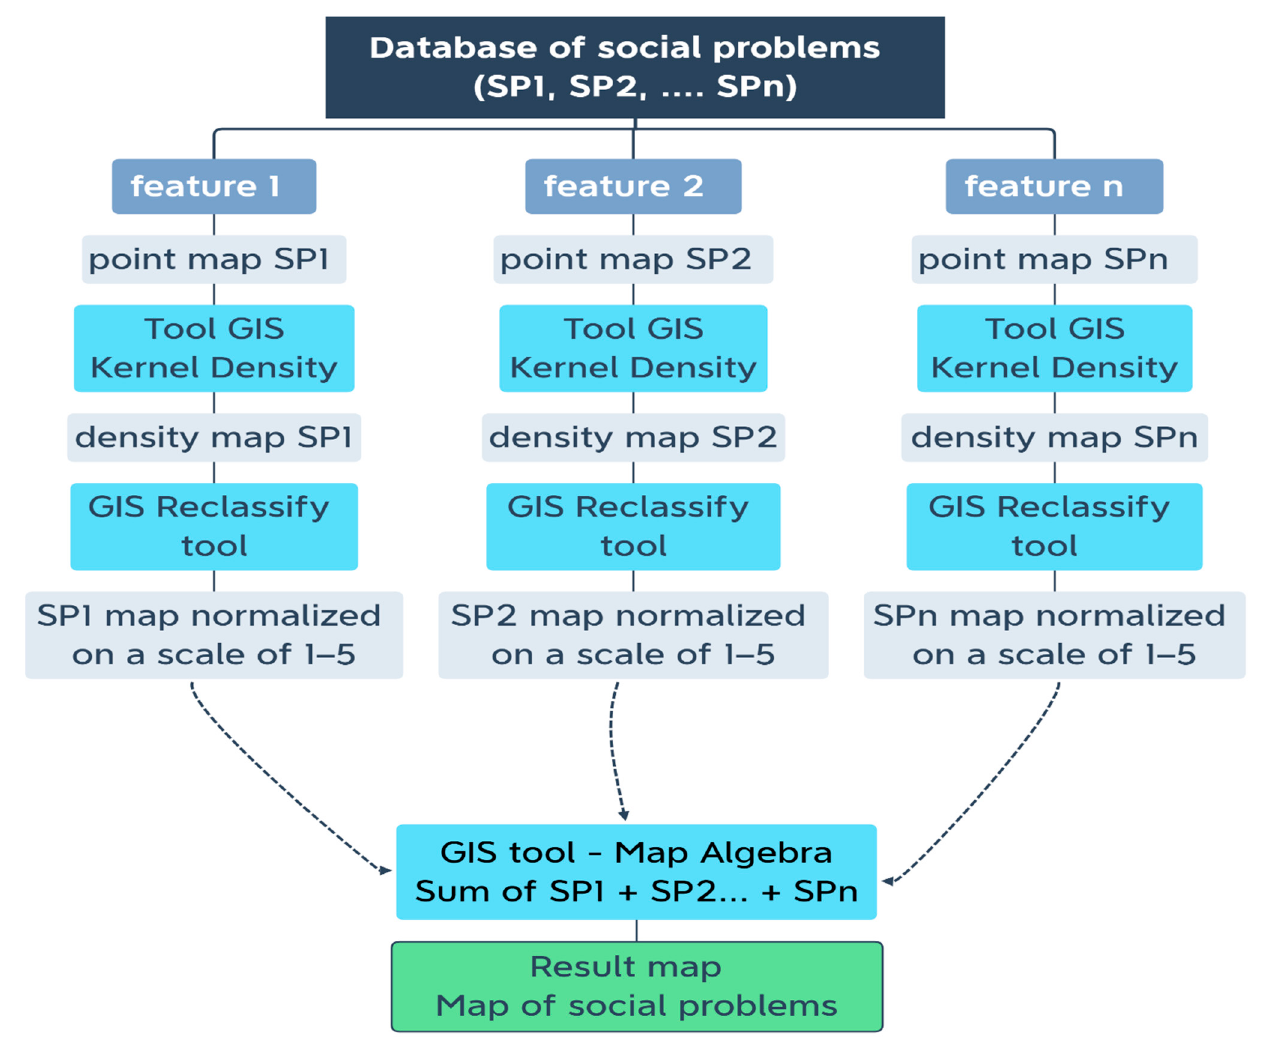
Figure 2. Algorithm developed in the GIS environment for mapping social problems. Source: Own elaboration.